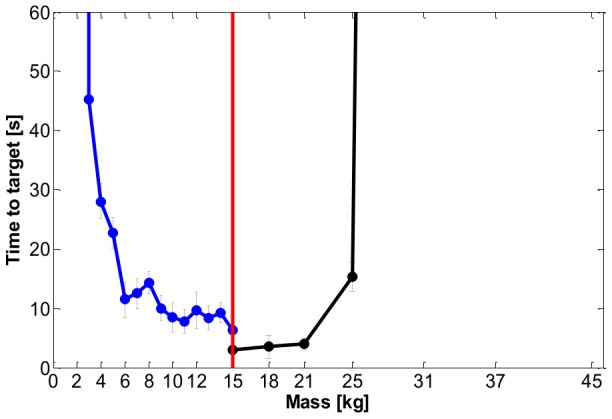
Task A: sensitivity of a performance parameter (TT, Time to Target) to variations of the virtual mass.The blue curve corresponds to the PSS: in this case, the damping factor ζ is maintained constant and the values of the virtual mass and of viscosity are reduced systematically from the nominal values, with a dramatic reduction of performance when the mass is reduced below 6 kg. The black curve corresponds to the SSS: in this case the damping factor ζ is reduced in steps from 0.7 to 0.1, by increasing accordingly the value of the virtual mass, with a dramatic breakdown of performance when the mass exceeds 25 kg. The data represent mean values (with the corresponding standard errors) for the subject that performed the sensitivity task.